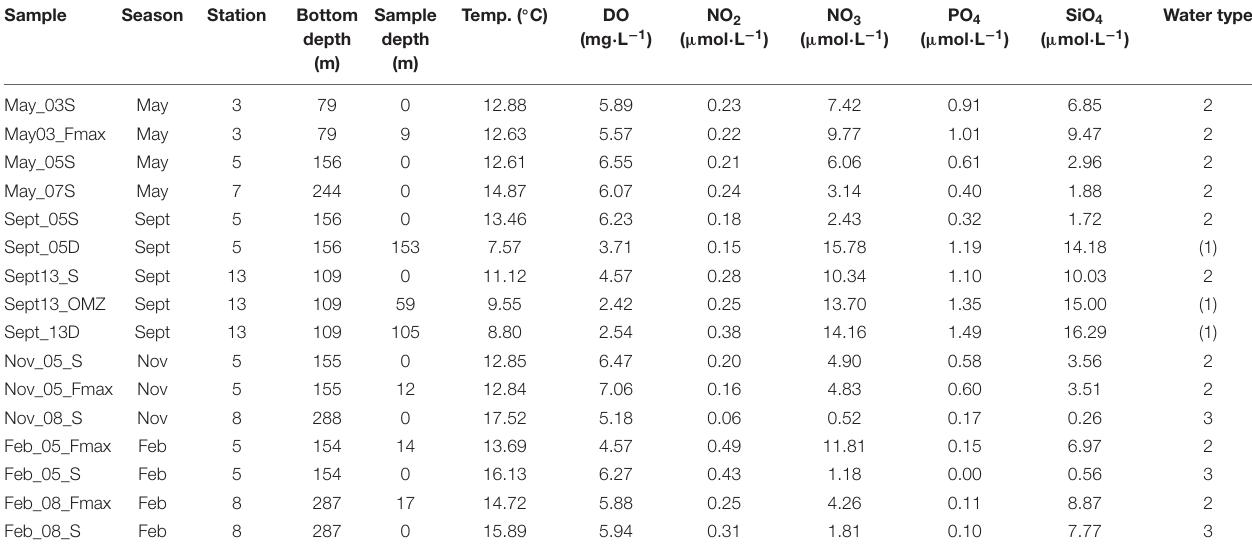
TABLE 1 | Physico-chemical variables measured for each of the microbial samples collected from stations 3, 5, 7, 8 and 13 on the St Helena Bay Monitoring Line in May, September and November 2015 and February 2016. Sample Season